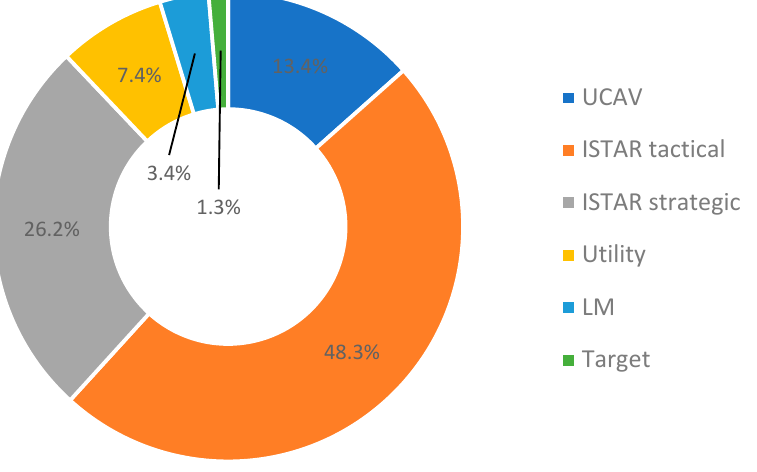
Power Table 4. Indicative results for UAVs of di ff erent NATO categories (“Current”) and comparison with the actual values (“Actual”) and the reference literature [24] (“Ref.”). UAV Region GTOW Span (Actual) Span (Ref.) Span (Current) Error (Ref.)